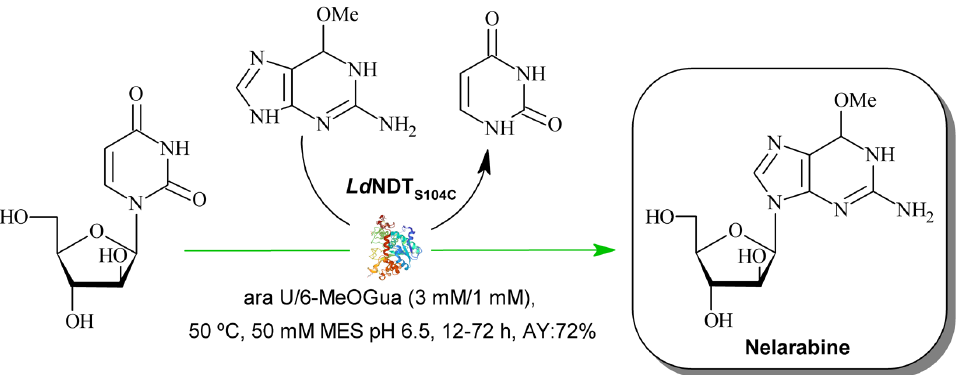
Figure 1. NDT-mediated synthesis of nelarabine. Ara U: arabinosyl uracil; MeOGua: 6-methoxygua- NDT-mediated synthesis of nelarabine. Ara U: arabinosyl uracil; MeOGua: 6- nine; AY: assay yield. methoxyguanine; AY: assay